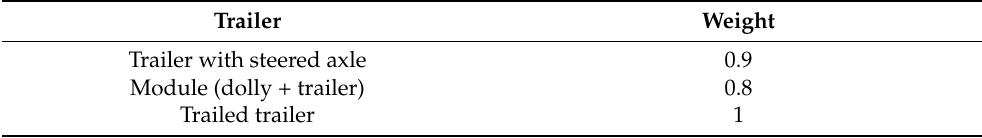
Table 3. Weights assigned to the